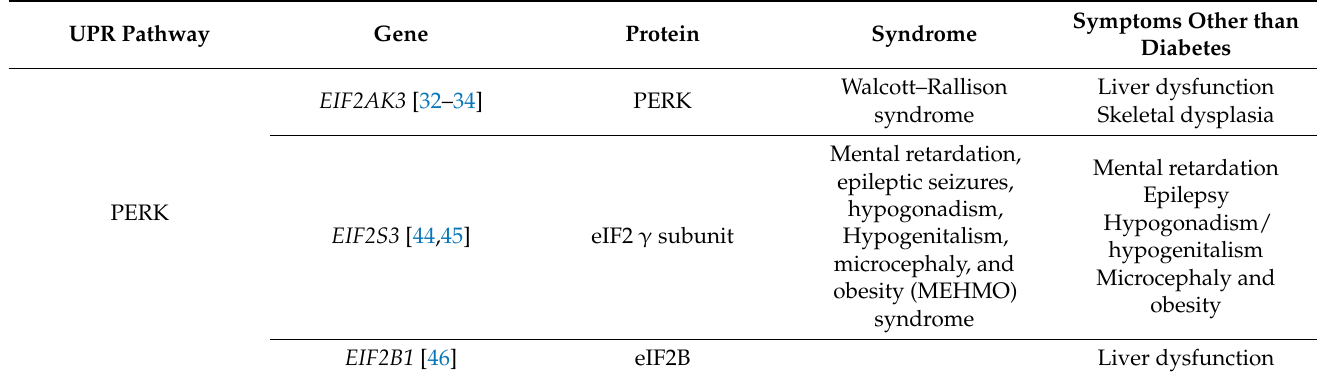
Table 1. Genetic Variants in UPR Pathways that are Related to Diabetes. UPR